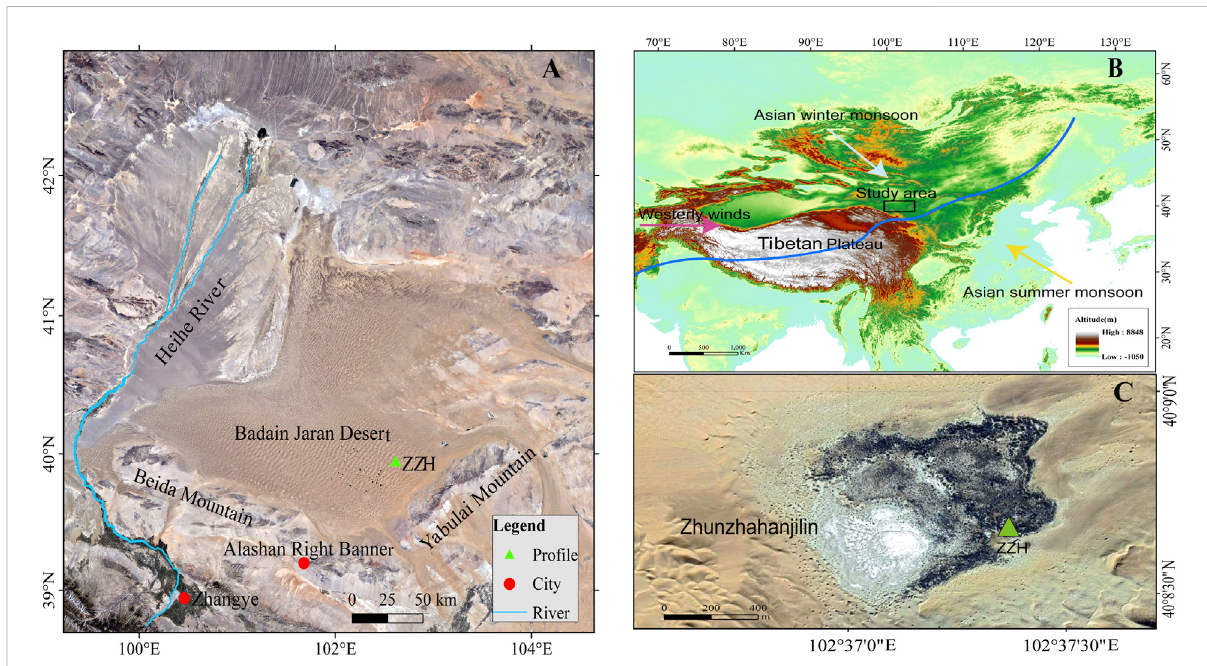
FIGURE 1 (A) Location of the ZZH pro fi le in the southeastern part of the Badain Jaran Desert. (B) The black square on the map shows the location of the study area in northwestern China, and the blue line shows the limit of the Asian summer monsoon. The white arrow indicates the Asian winter monsoon, the yellow arrow indicates the Asian summer monsoon, and the purple arrow indicates the westerly winds. (C) The ZZH pro fi le within the Zhunzhahanjilin arid lake